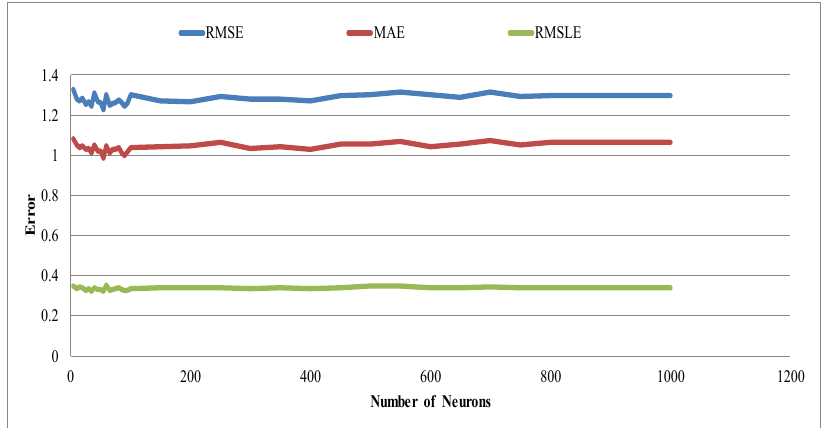
Figure 9. Table showing the number of neurons for the range of 0 – 1000 against error metrics (RMSE, MAE, and RMSLE) for one hidden layer in the validation group. The three metrics are average values.